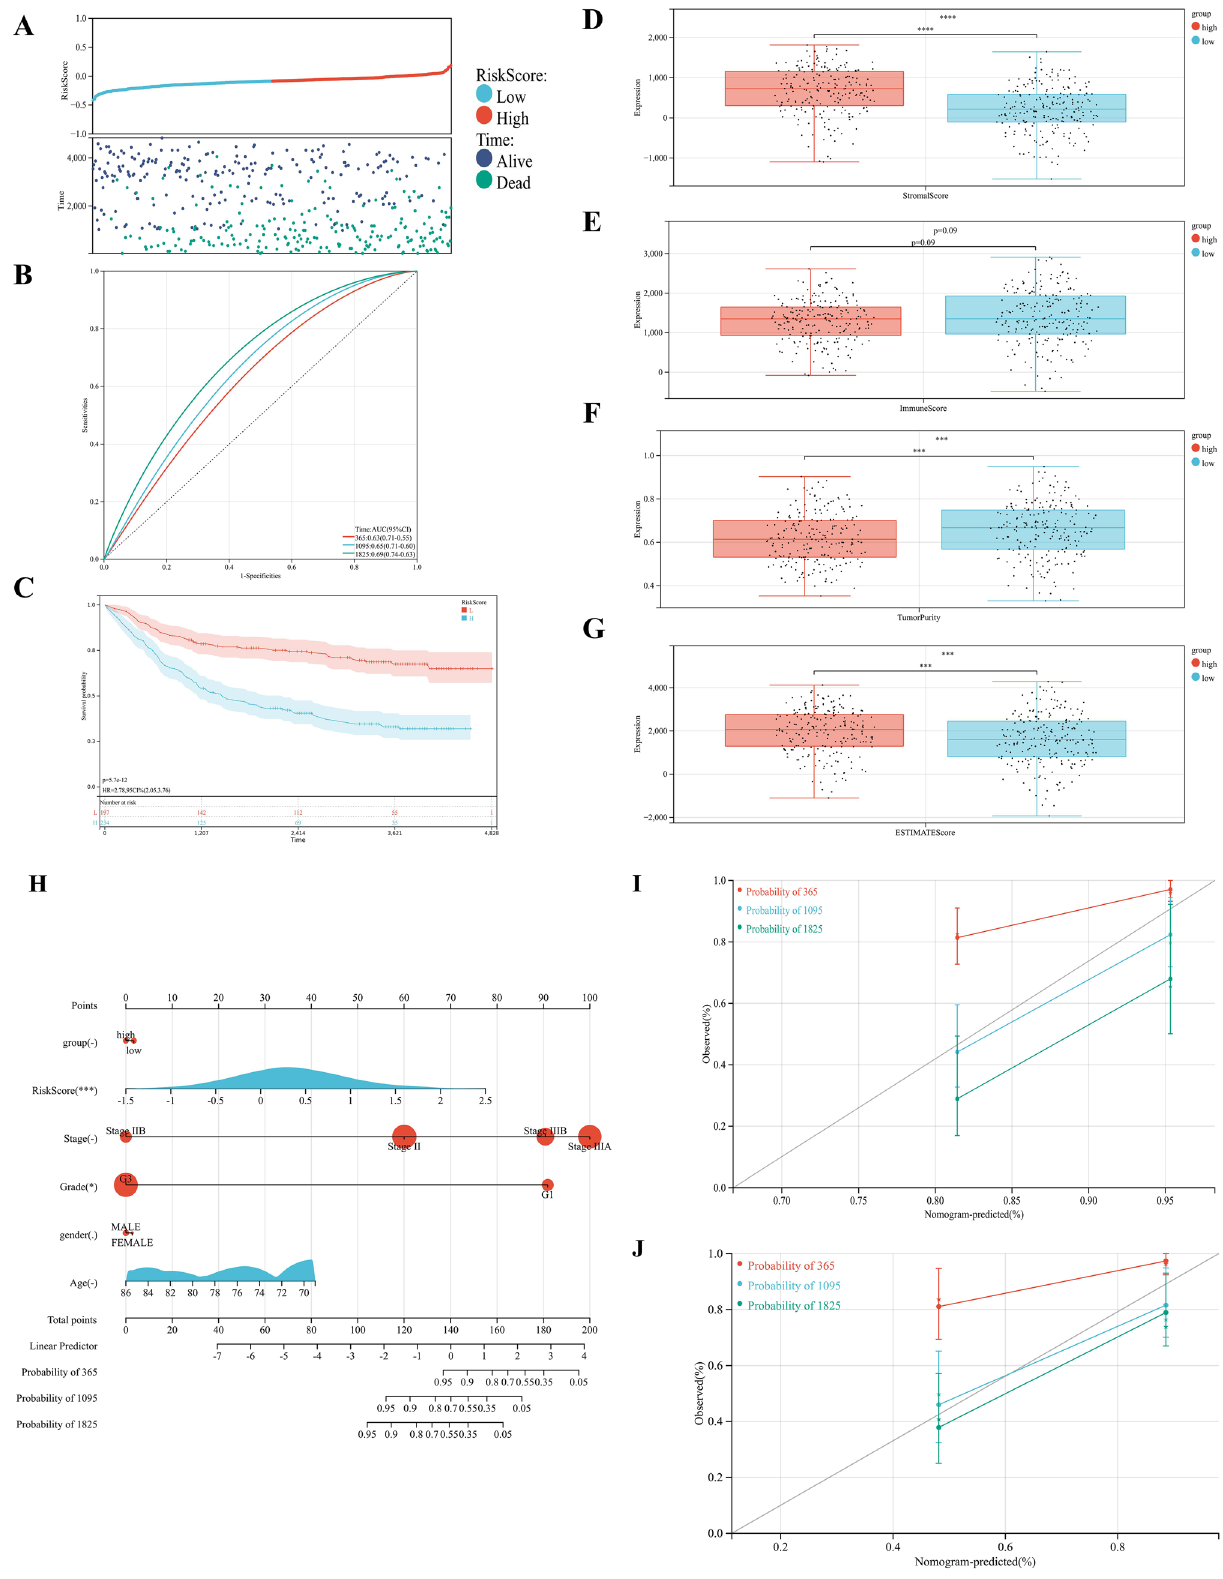
Figure 8. Validation of prognostic risk signature in validation cohort. ( A ) Distribution of survival status and risk score in the high and low risk groups. ( B ) ROC curve of the risk signature in validation cohort. ( C ) Survival curve of the patients in the high and low risk groups. ( D – G ) Stromal score, Immune score, Tumor Purity, and ESTIMATE score calculated by ESTIMATE algorithm (* p < 0.05; ** p < 0.01; *** p < 0.001). ( H ) Nomogram integrating risk score and clinical features. ( I ) Calibration of the nomogram at 1,3, and 5 years in the training cohort (* p < 0.05; ** p < 0.01; *** p < 0.001). ( J ) Calibration of the nomogram at 1,3, and 5 years in the validation cohort (* p < 0.05; ** p < 0.01; *** p <